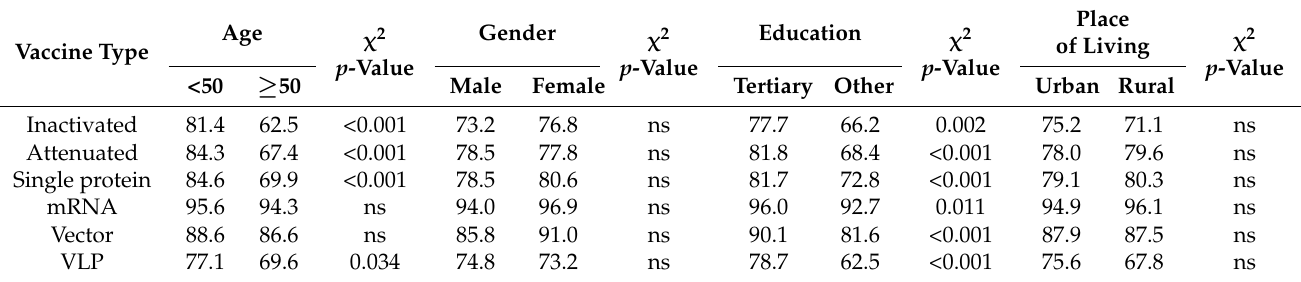
Table 2. The percentage of individuals in the studied group ( n = 1020) aware of the particular vaccine type in relation to age, gender, education and place of living. Vaccine